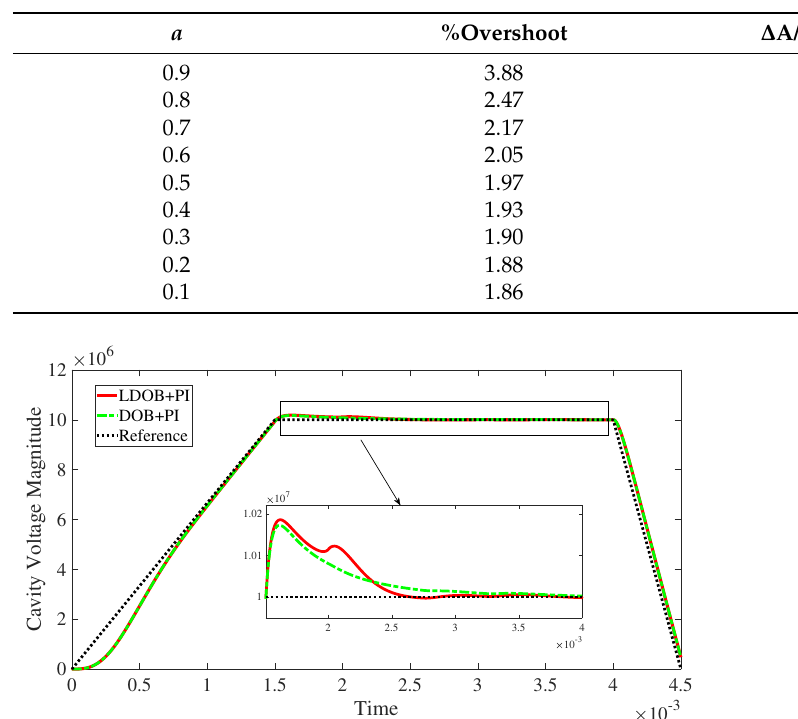
Figure 11. Effect of recursive coefficient a on cavity voltage magnitude transients, elaborating overshoot and magnitude stability in flat top. Table 4. Effect of recursive coefficient a on overshoot and magnitude stability.